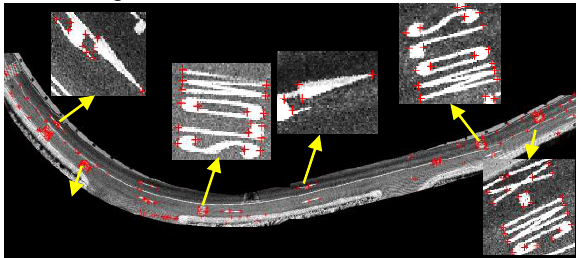
Figure 2. Feature points detected by the Harris operator from the intensity image. Red-crosses are the detected corner points, though there are many random noises in the intensity